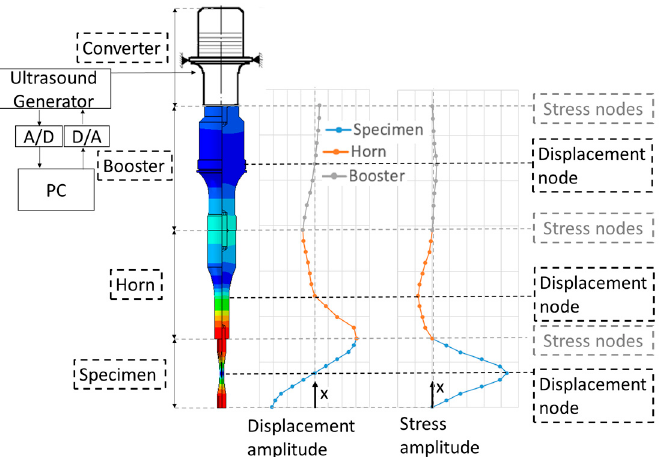
Figure 1. Ultrasonic testing machine layout, stress, and displacement amplitudes, adapted from [1].